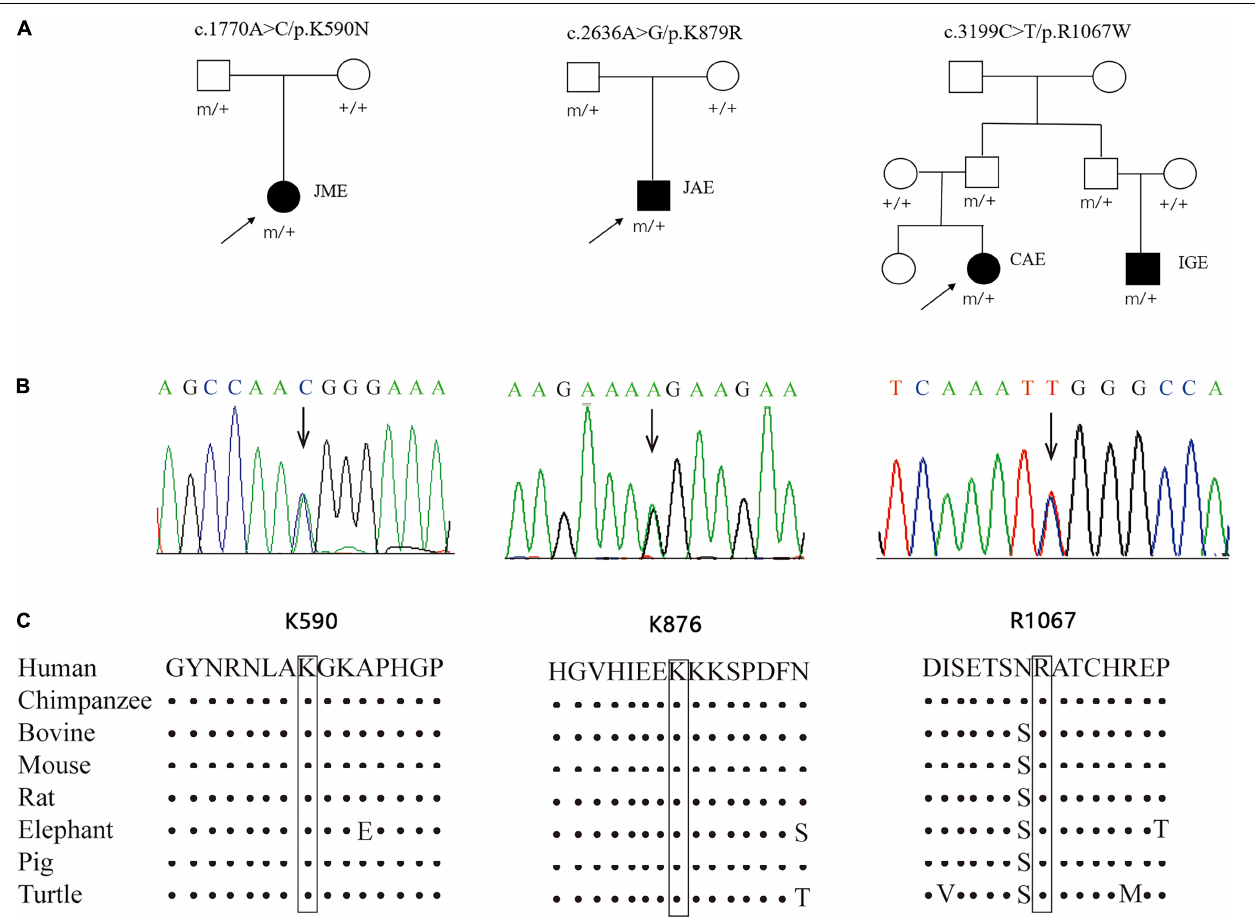
FIGURE 1 | Genetic data about GRIN2A mutations. (A) Pedigrees of the three cases with GRIN2A mutations and their corresponding phenotypes. (B) DNA sequence chromatogram of the GRIN2A mutations. Arrows indicate the positions of the mutations. (C) The amino acid sequence alignment of the three mutations shows that residues K590, K879, and R1067 were highly conserved across vertebrates. JME, juvenile myoclonic epilepsy; JAE, juvenile absence epilepsy; CAE, childhood absence epilepsy; IGE, idiopathic generalized epilepsy.